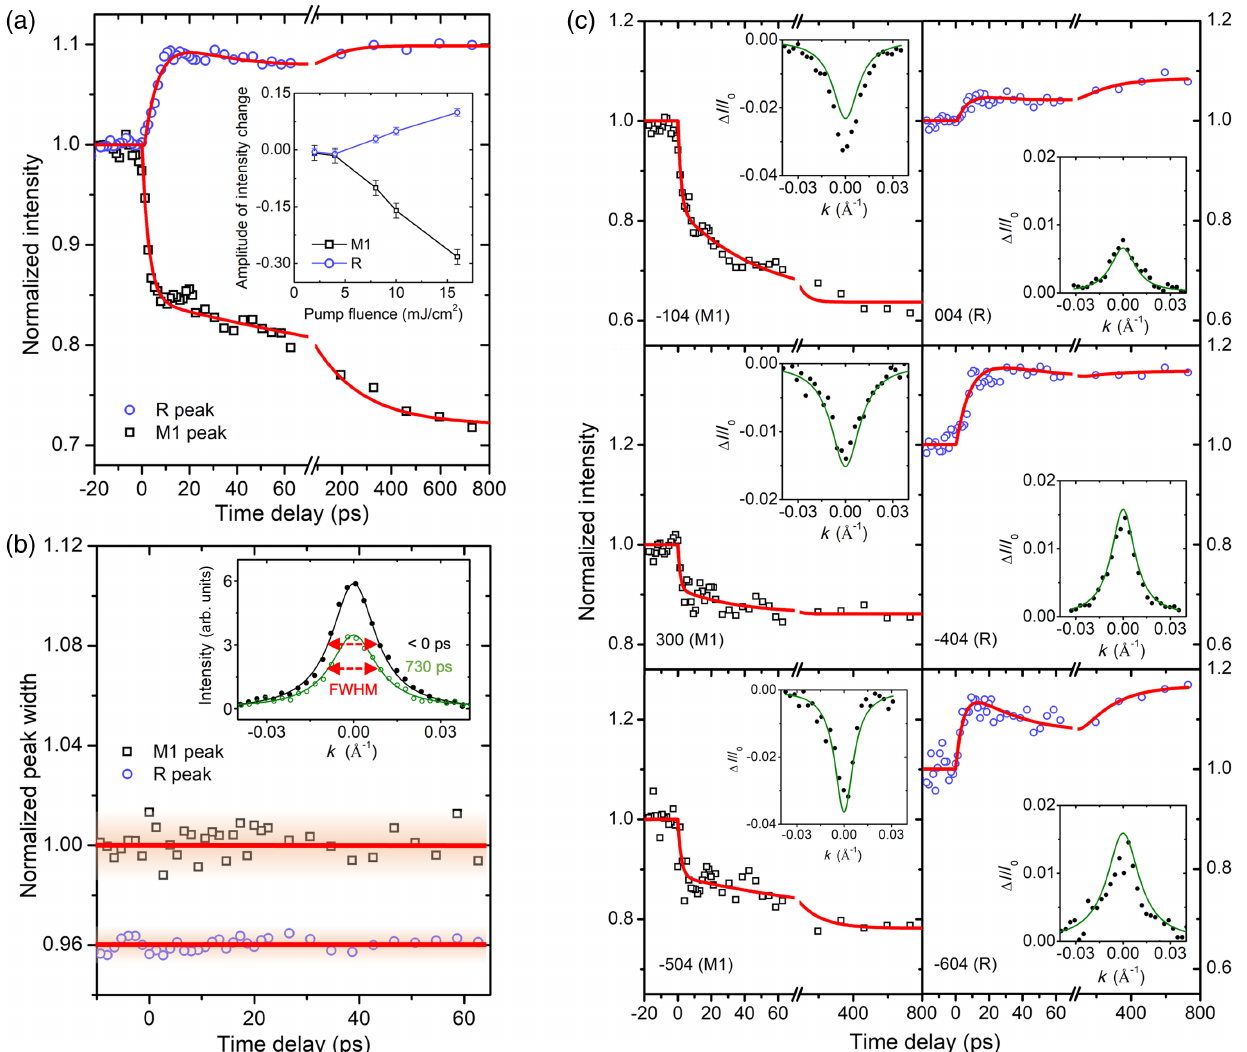
FIG. 2. Photoinduced lattice dynamics. (a) Normalized relative intensity changes of the R peaks (averaging over − 402 , − 202 , 002, 202, − 604 , − 404 , − 204 , 004, 200, 400 reflections) and M1 peaks (averaging over − 104 , 300, − 302 , − 304 , − 506 , − 504 , − 102 , − 306 , 102, − 502 reflections) during the photoinduced structural evolution under pump fluence of 16 mJ = cm 2 . The simultaneous increase of R peak and decrease of M1 peak intensity clearly indicate the suppressing of M1 phase upon photoexcitation. Inset: normalized intensity changes of M1 and R peaks as a function of fluence at 730 ps. (b) The averaged peak width of the M1 and R reflections over time, no visible change is observed. Inset: intensity profile of M1 peak ( − 104 ) at time delay t ¼ 0 ps (black dots) and t ¼ 730 ps (open green circles). The solid lines are fitting curve based on the Lorentzian function. Although the peak intensity decreases at t ¼ 730 ps, the peak width (FWHM) remains constant compared to that at t ¼ 0 . (c) Temporal evolution of normalized intensity of various M1 peaks ( h 0 l with h ¼ 2 n þ 1 ) and R peaks ( h ¼ 2 n ) averaged over symmetry allowed reflections ( − h 0 l=h 0 − l and h 0 − l= − h 0 l ) under pump fluence of 16 mJ = cm 2 . The red curves are guides to the eyes based on fitting with a double or triple exponential function. All the data shown in (c) were carried out at base sample temperature of 314 K. The measurement errors of normalized peak intensity change, mostly due to shot-to-shot variation of electron beam intensity, are 0.02 (300), 0.02 ( − 104 ), 0.03 ( − 504 ), 0.009 (004), 0.018 ( − 404 ), and 0.015 ( − 604 ) (reflection index is indicated in parenthesis), with an integration of 700 shots at each time delay. For clarity, the measurement errors are not plotted in the figure. Insets: quantitative comparisons of normalized experimental (solid dots) and calculated (green curves) intensity changes at 730 ps for the major M1 and R peaks. The calculations are the best fit to the displacement along the a and c axes and the Debye-Waller factors obtained from the